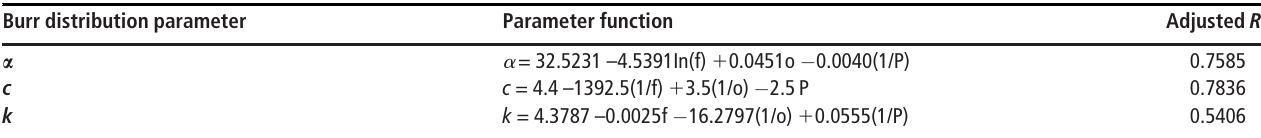
Table 4 Parameter functions of the best distribution models Burr distribution